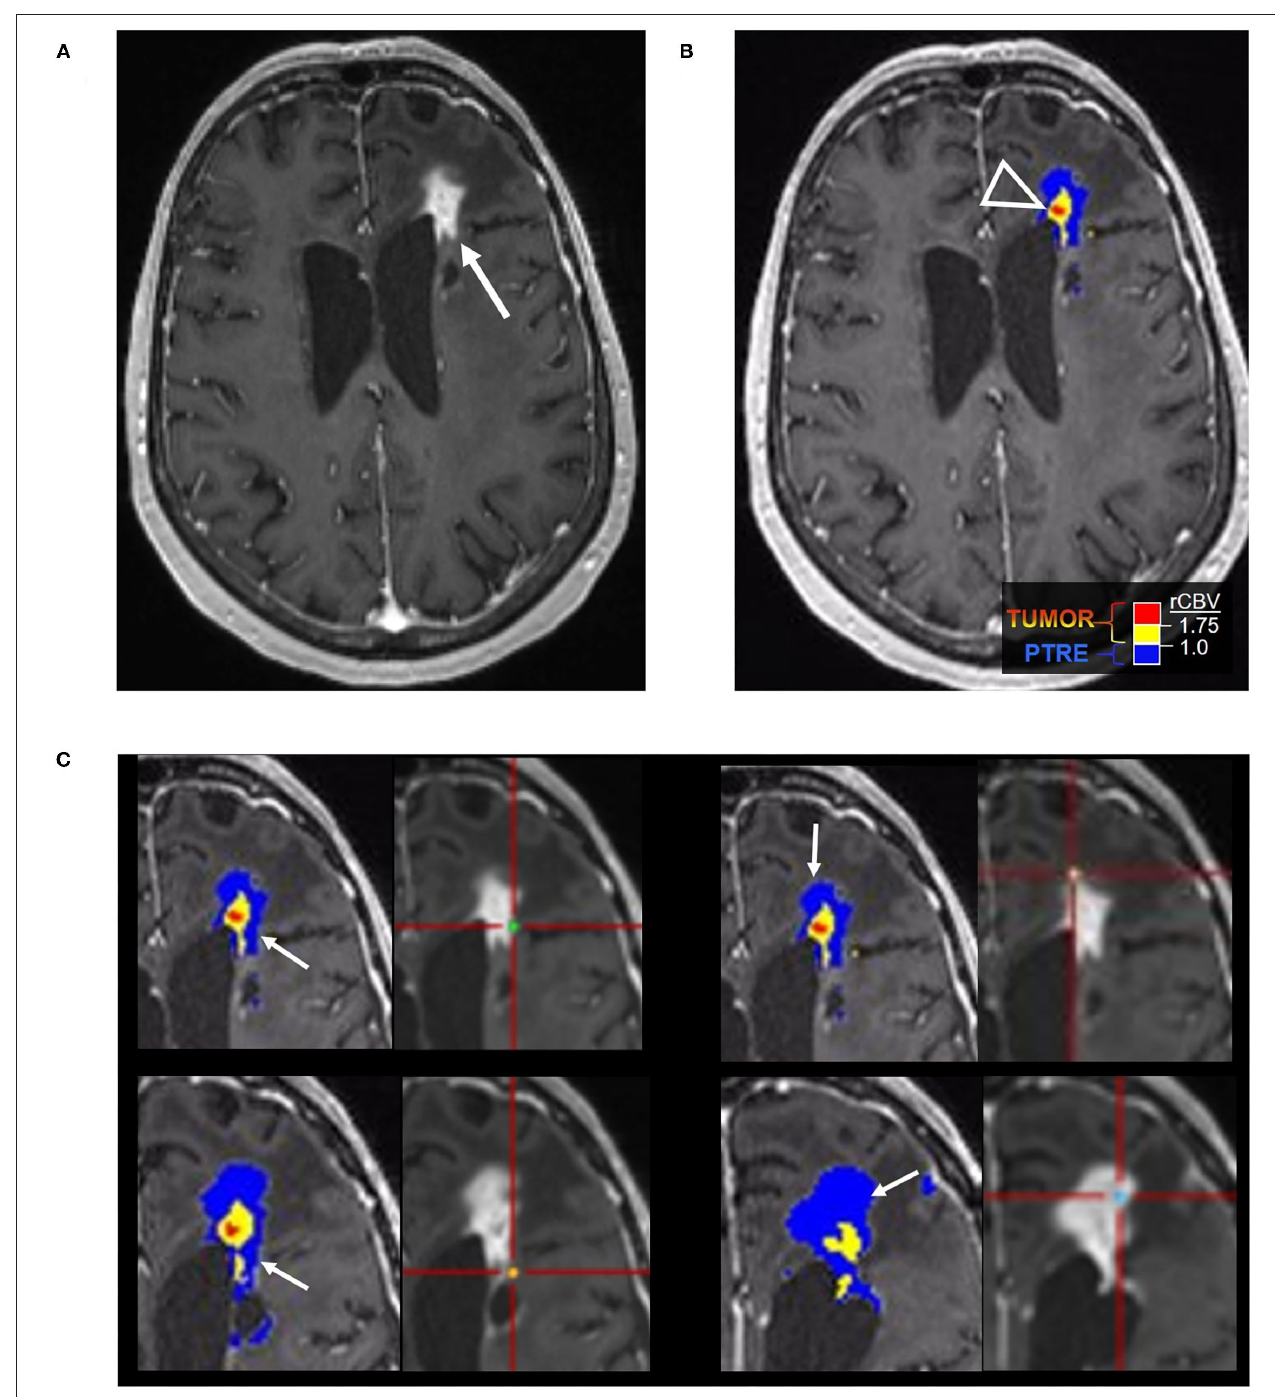
FIGURE 2 | Posttreatment changes on DSC-MRI: A 68-year-old woman with left frontal GBM with two prior surgical resections and adjuvant radiation, temozolomide, and lomustine therapy undergoing routine surveillance imaging. (A) CE-MRI 2 years after initial diagnosis demonstrated increased nodular enhancement along the resection cavity concerning recurrent tumor. (B) The DSC FTB map derived from relative cerebral blood volume (rCBV) thresholds demonstrate a small area of high FTB centrally (arrowhead) suggesting tumor recurrence, but the majority of the surrounding tissue had low rCBV consistent with posttreatment effect. (C) Stereotactic biopsies were performed and cross-registered with areas of enhancement, but only corresponded with low rCBV regions. Pathology showed scant atypical cells in a background of extensive therapy-related changes, compatible with the rCBV map. No viable GBM was identified. Unfortunately, the central portion of the tumor was not sampled and cross-registration with the DSC images at the time of biopsy may have been helpful in fully characterizing the lesion pathologically.